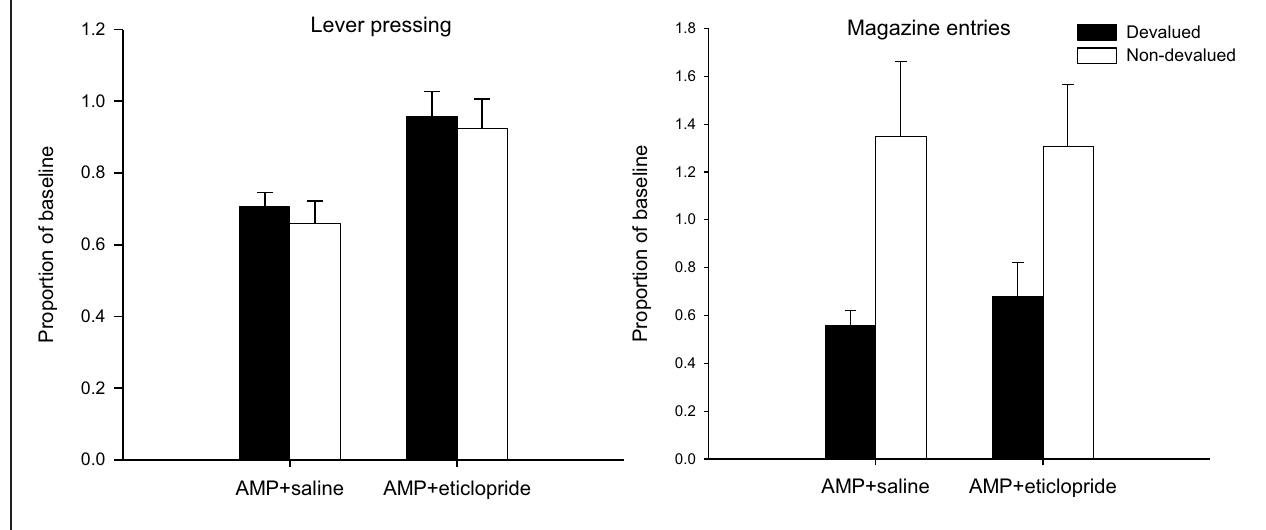
FIGURE 3 | Effect of eticlopride following amphetamine sensitization on sensitivity of lever pressing (left-hand panel) and magazine entry (right-hand panel) to reward devaluation by LiCl-induced nausea. Mean